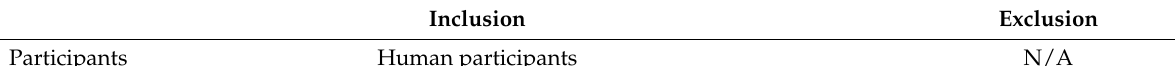
Table 1. Inclusion and exclusion criteria for scoping